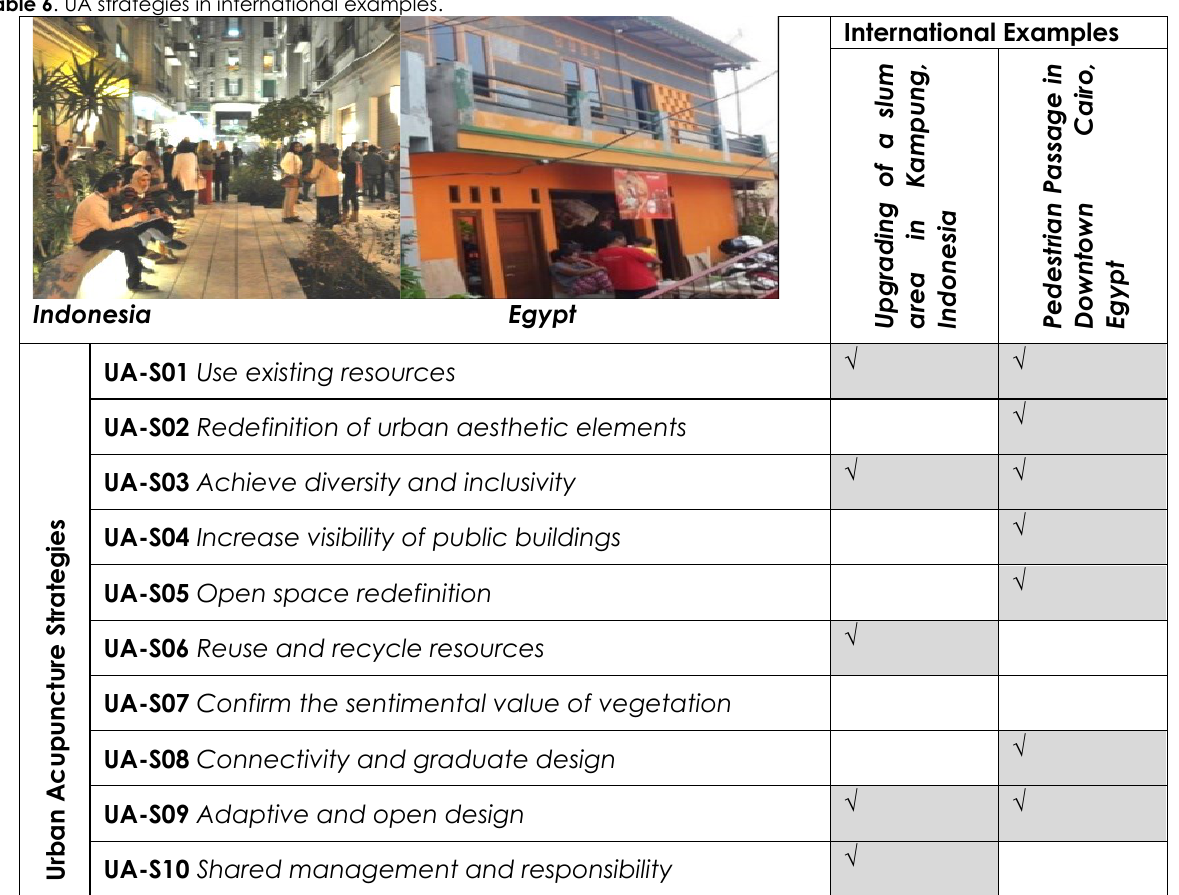
Table 6 . UA strategies in international